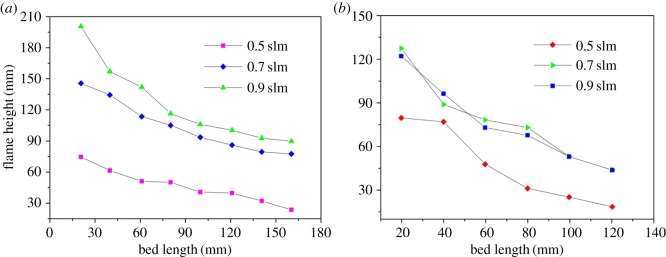
Variation of flame height as a function of bed length for different VCH4 at d = 1 mm, α=1.2. (a) d = 3.5 mm; (b) d = 6.5 mm.